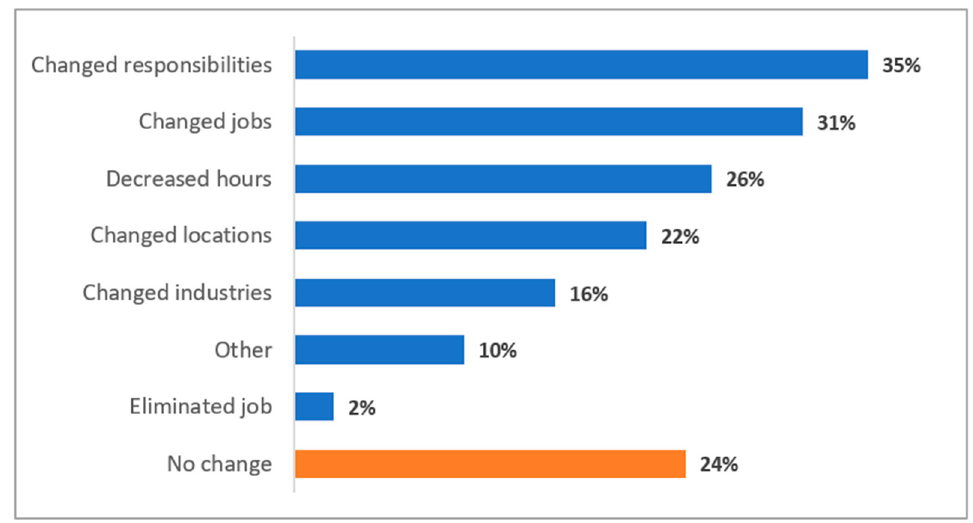
Figure 5. COVID-19 impact on current employment ( n = 124).